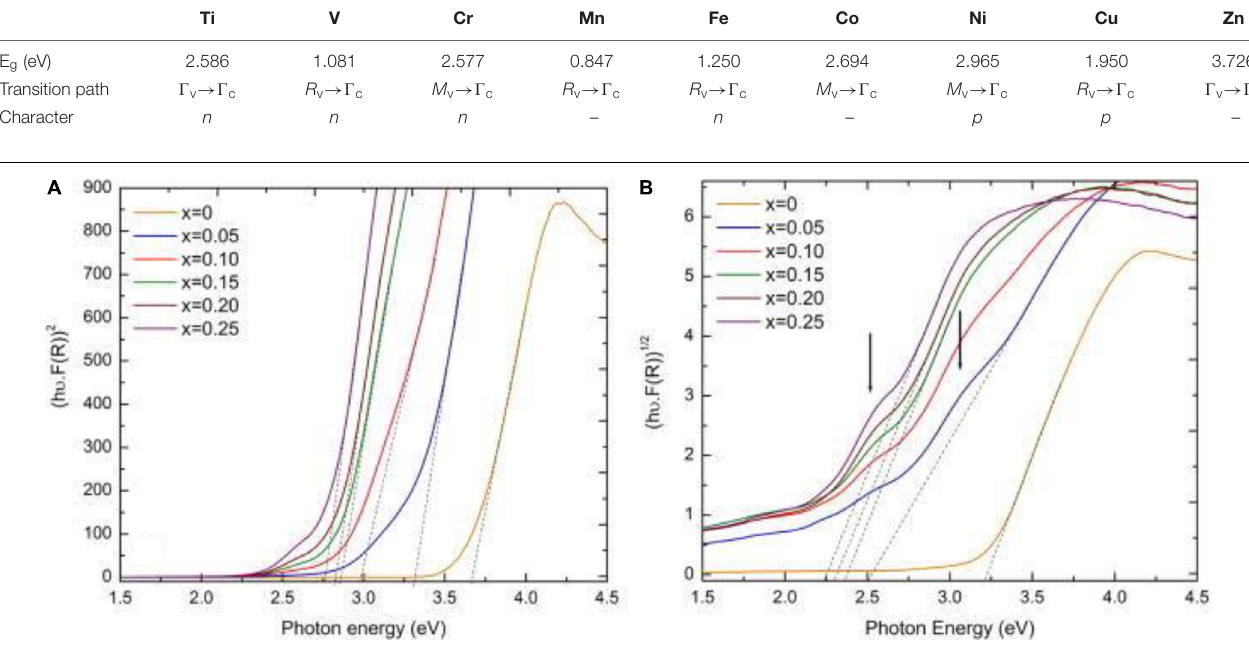
FIGURE 10 | Tauc plot for (A) direct and (B) indirect bandgaps for KNBF (0 ≤ x ≤ 0.25) ceramics ( x increases from right to left). [Reproduced from https://doi.org/10.1063/1.4982600, https://creativecommons.org/licenses/by/4.0/ (Pascual-Gonzalez et al., 2017)].